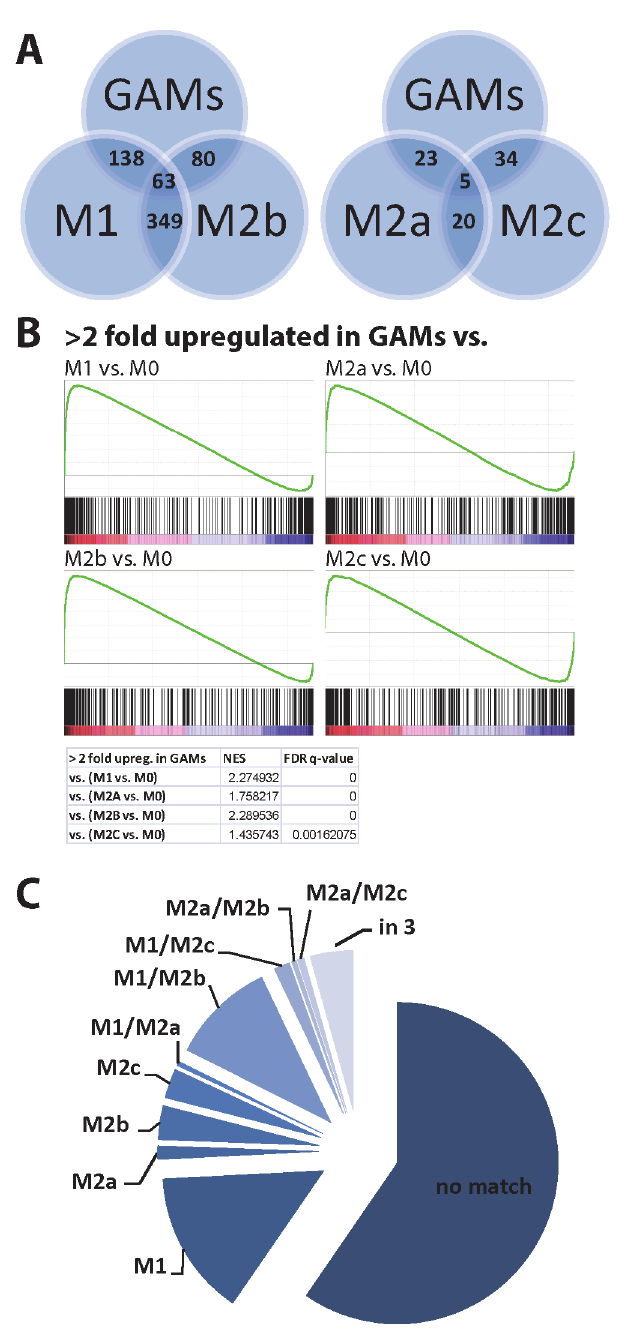
Fig 3. Comparison of GAMs with data sets of M1, M2a,b,c-stimulated macrophages. We retrieved data sets from http://www.ebi.ac.uk/arrayexpress (Data set: E-GEOD-32690; [44]), containing data of macrophages that were stimulated for 24 h in vitro into different polarization states (M0 (unstimulated), M1 (IFN γ + LPS), M2a (IL4), M2b (IFN γ + complexed Ig), and M2c (Dexamethasone)) and compared which genes in these data sets significantly overlapped with glioma-regulated genes in our GAMs data set. A: A graphical representation of the overlap of upregulated genes in GAMs and the four macrophage data sets. The GAMs gene expression profile shows the greatest number of overlaps with M1, and M2b polarized macrophages. B: Using Gene Set Enrichment Analysis (GSEA) we found that the 438 upregulated genes in GAMs are significantly enriched in the upregulated genes of all four macrophage polarization sets. C: Only a minority of genes upregulated in GAMs were also induced in the M1 to M2c phenotype, 59.5% of the genes that were upregulated in GAMs were not regulated in any of the four macrophage phenotypes.